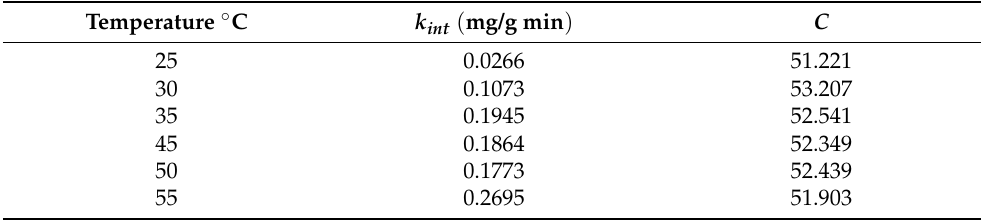
Table 2. Intra-particle diffusion parameters for Pb 2+ sorption onto the modified ZnO NP/DPF sorbent at different